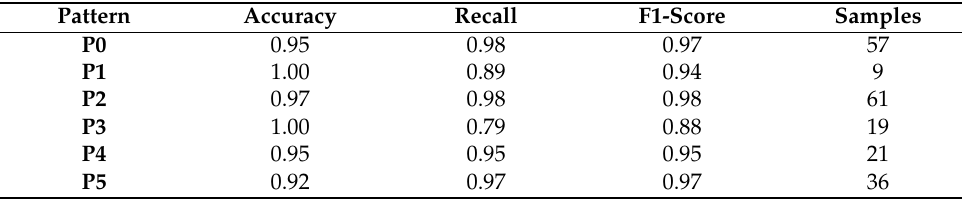
Table 8. Accuracy per